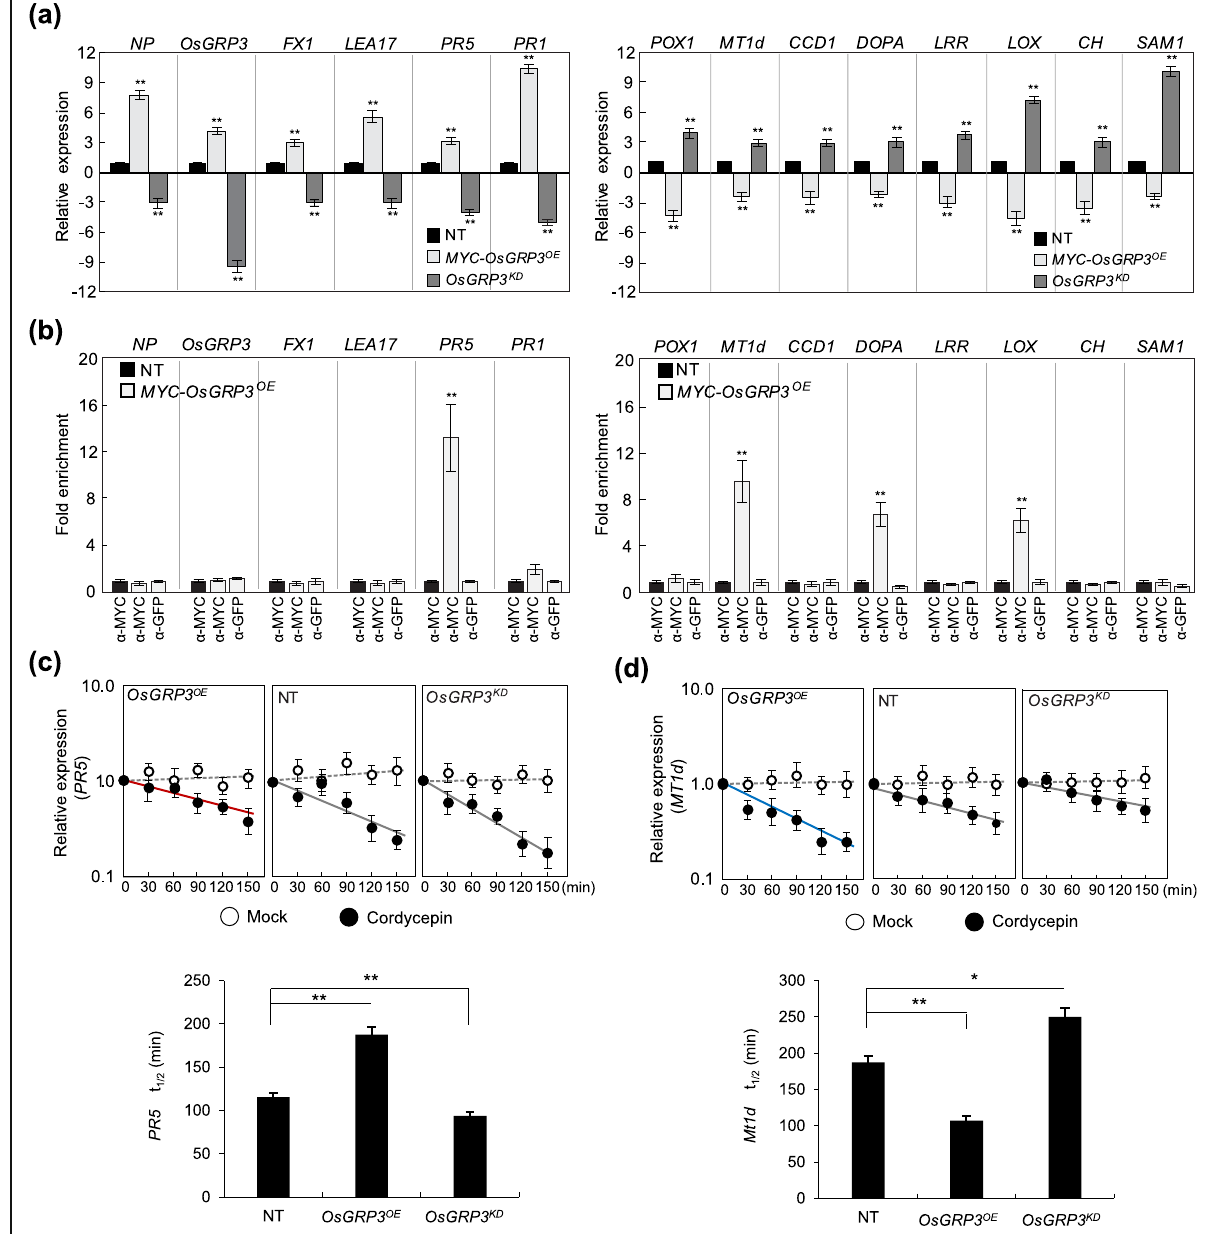
Fig. 5 OsGRP3 affects the stability of its binding transcripts a Validation of expression levels of DEGs isolated from RNA sequencing analysis in non-transgenic plants (NT), MYC - OsGRP3 overexpressing ( MYC-OsGRP3 OE ) and RNAi-mediated OsGRP3 suppressing ( OsGRP3 KD ) transgenic plants by qPCR analysis. Total RNAs were isolated from leaves of two-week-old NT, MYC-OsGRP3 OE and OsGRP3 KD transgenic plants. Rice UBIQUITIN ( OsUBI ) was used as an internal control for normalization. b Analysis of OsGRP3 interaction with the transcripts of the selected DEGs. Leaves of two-week- old MYC-OsGRP3 OE and NT plants were used for RNA-IP experiments. The anti-GFP antibody was used as a negative control for the anti-MYC antibody. Fold enrichment was normalized to the value of NT plants. a and b Data represent the mean value ± standard deviation (SD) ( n = 3, biological replicates). Half-life measurement of c PR5 and d Mt1d transcripts. Two-week-old NT, OsGRP3 OE and OsGRP3 KD transgenic plants were pre-treated with 1 mM cordycepin for 30 min. Plants were then harvested every 30 min after mock or cordycepin treatments. Total RNAs extracted from the harvested samples were applied for qRT-PCR analysis. c and d Data represent the mean value ± standard deviation (SD) of three biological replicates. Half-lives of mRNA were calculated based on equation as shown in Table S5. Asterisks indicate a statistically significant difference compared with NT. ** P < 0.01; One-way